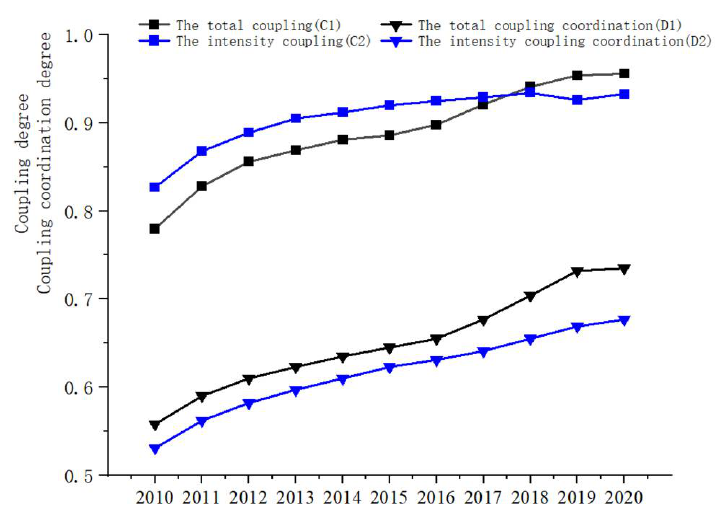
Figure 6. Coupling degree and coupling coordination degree of agricultural carbon emission reduc- tion and agricultural modernization.